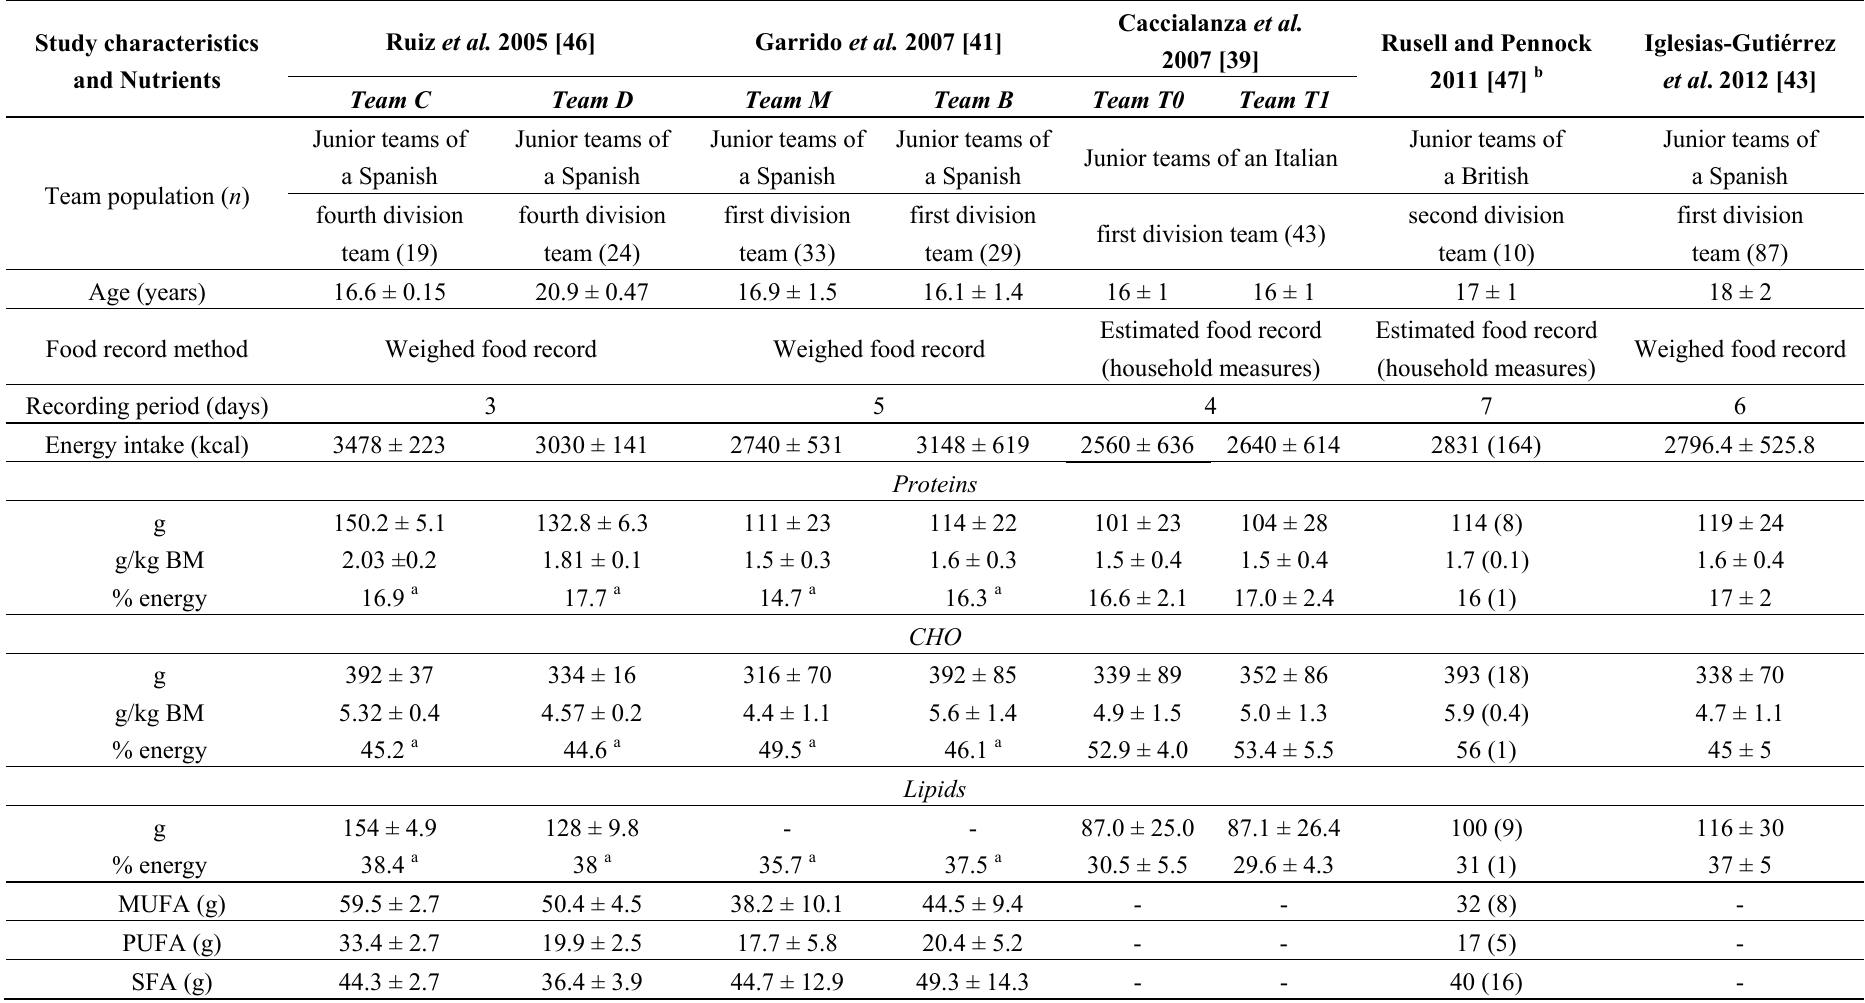
Table 1. Studies analyzing the nutritional intake of male soccer